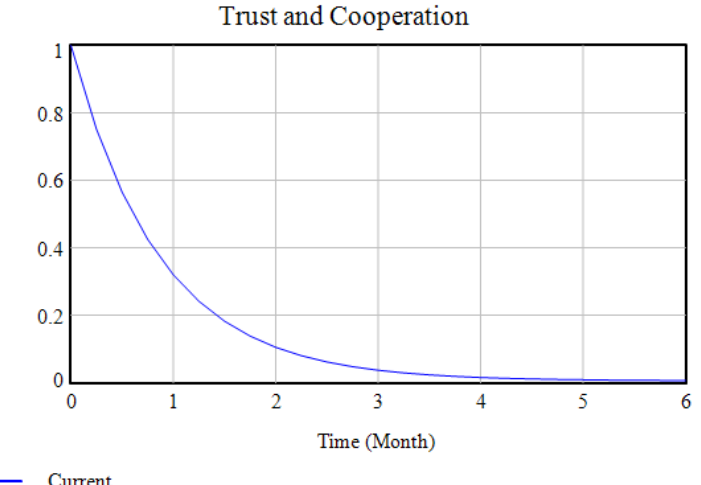
Figure 15. Simulation result of ‘Trust and Cooperation’.